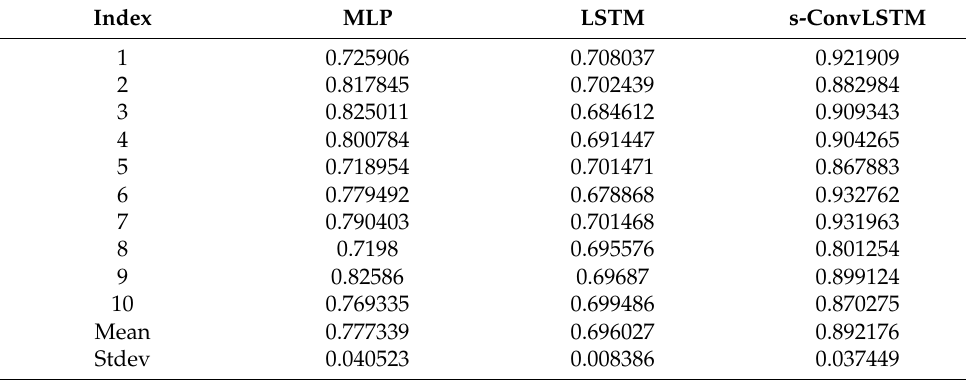
Table 6. Experiment results (PCC).